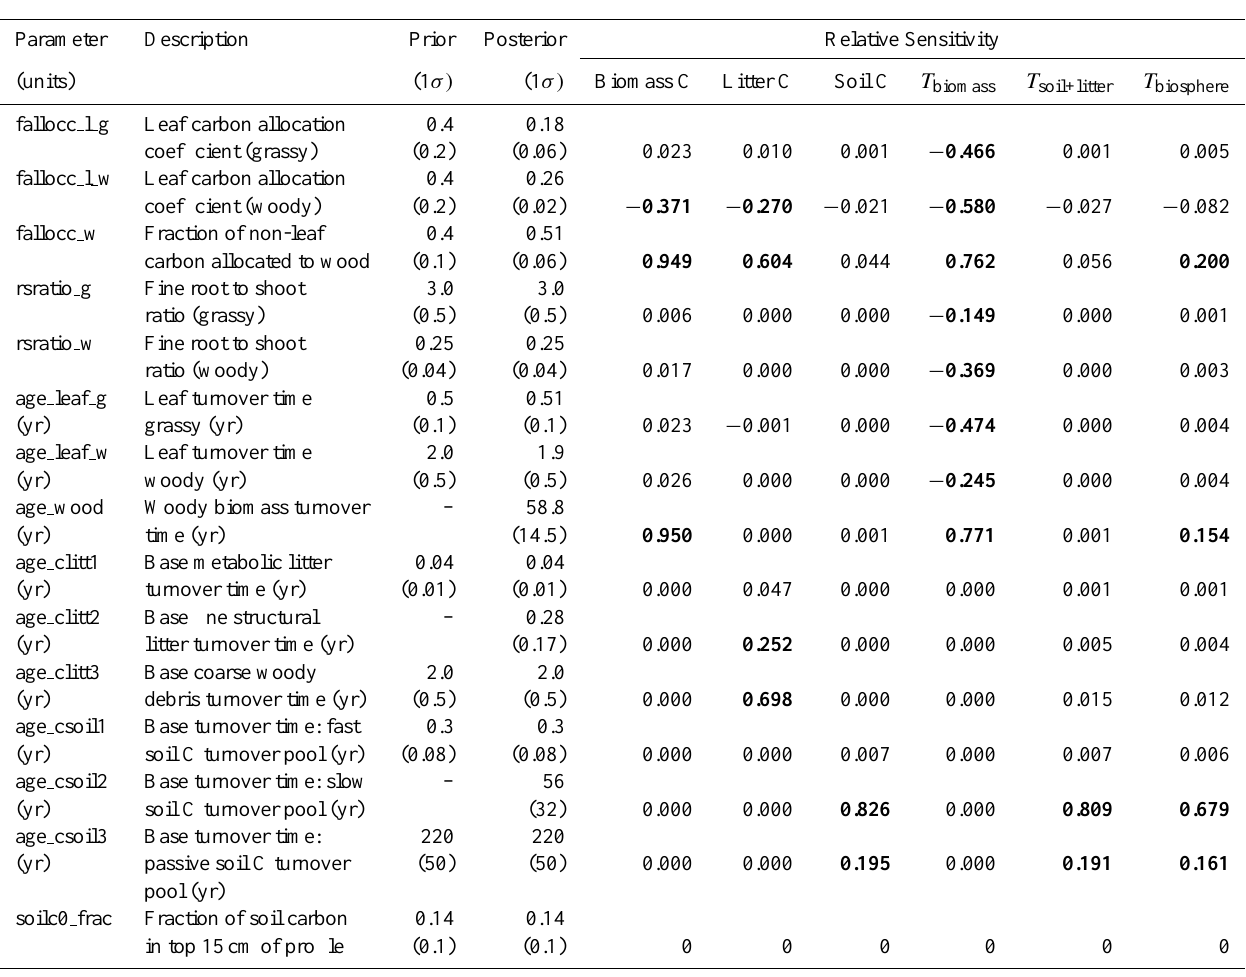
Table A3. Prior and posterior values of target parameters in CASA-CNP, and relative sensitivities of continental carbon pools and turnover times to